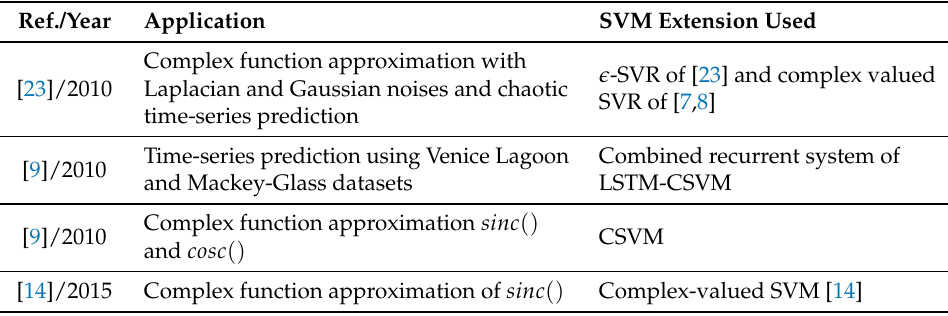
Table 4. Applications of complex and hypercomplex SVMs for time-series prediction and function approximation